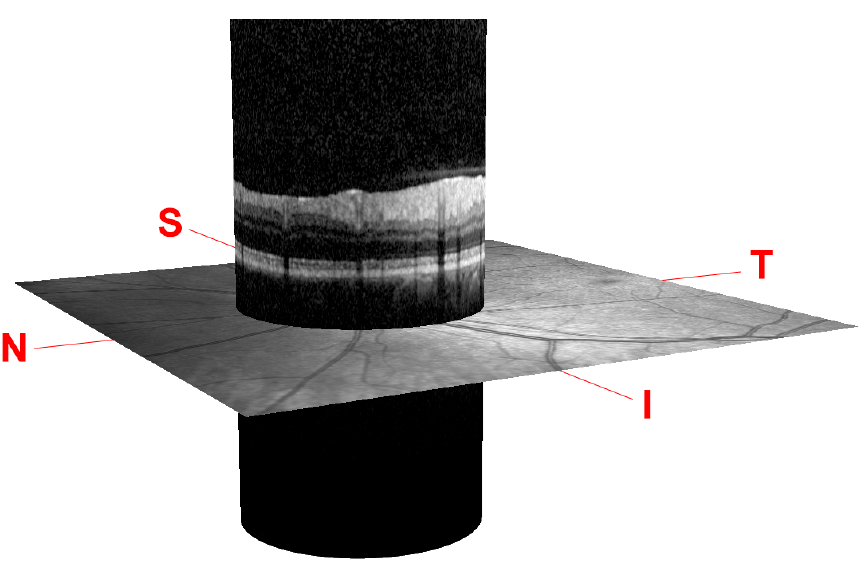
Figure 1. Peripapillary B-scan OCT centered on the optic disc and its relative axial position with respect to a retinal fundus image. Screenshot taken from the Spectralis OCT device. I, S, N, and T stand for inferior, superior, nasal, and temporal,